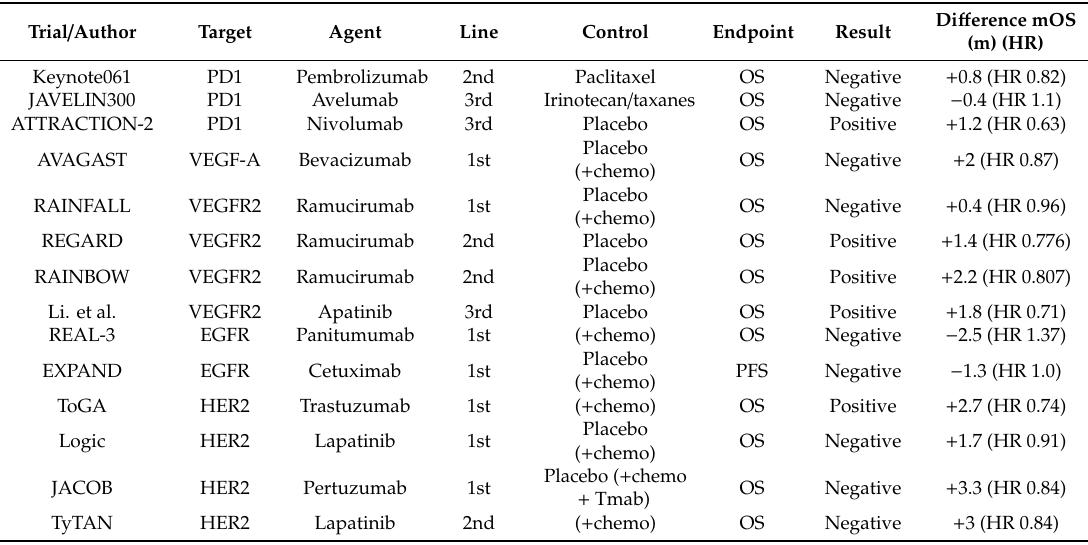
Table 2. Latest phase 3 target agents in gastric